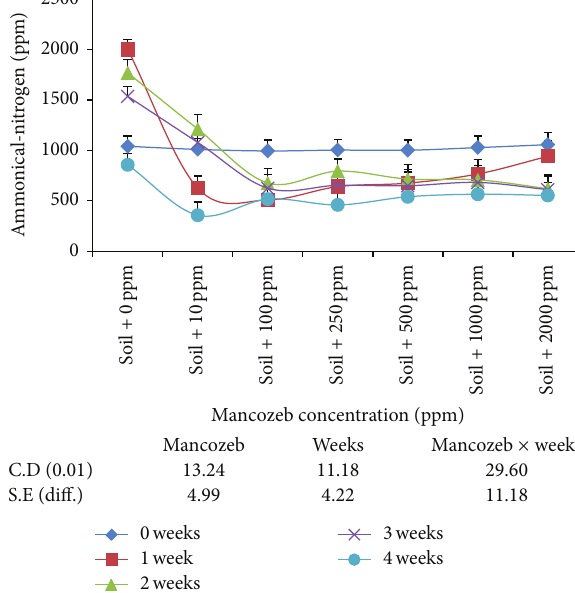
Figure 2: Effect of mancozeb on nitrifying bacterial population.